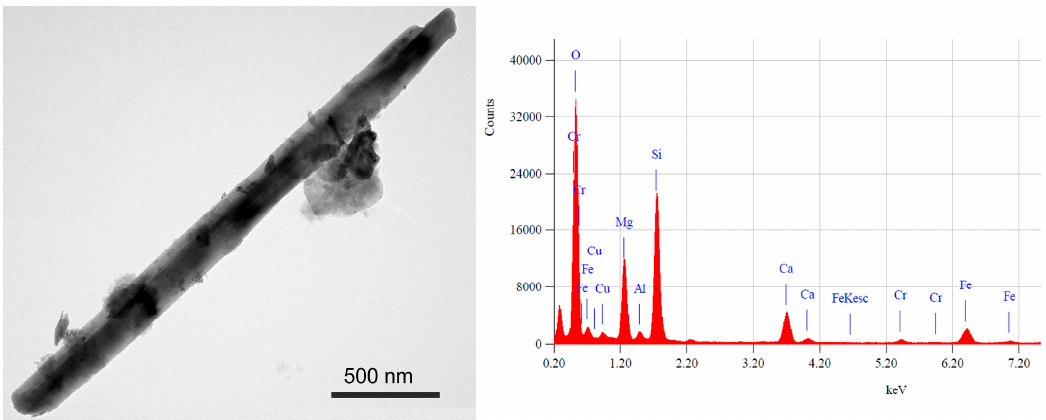
Figure 5. Single tremolite fiber with the relative point analysis (Spol1).